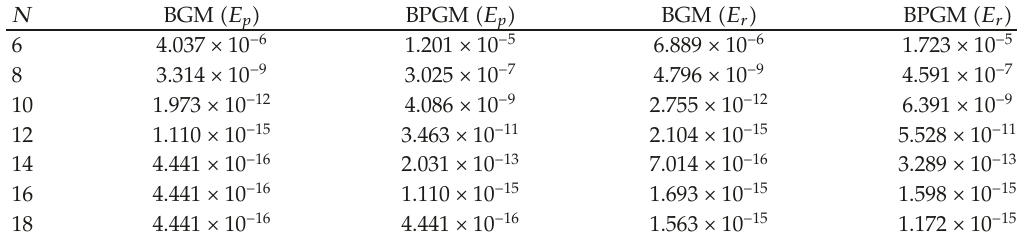
Table 4: (cid:7) E p (cid:8) and (cid:7) E r (cid:8) for N (cid:6) 6 , 8 ,... , 18.